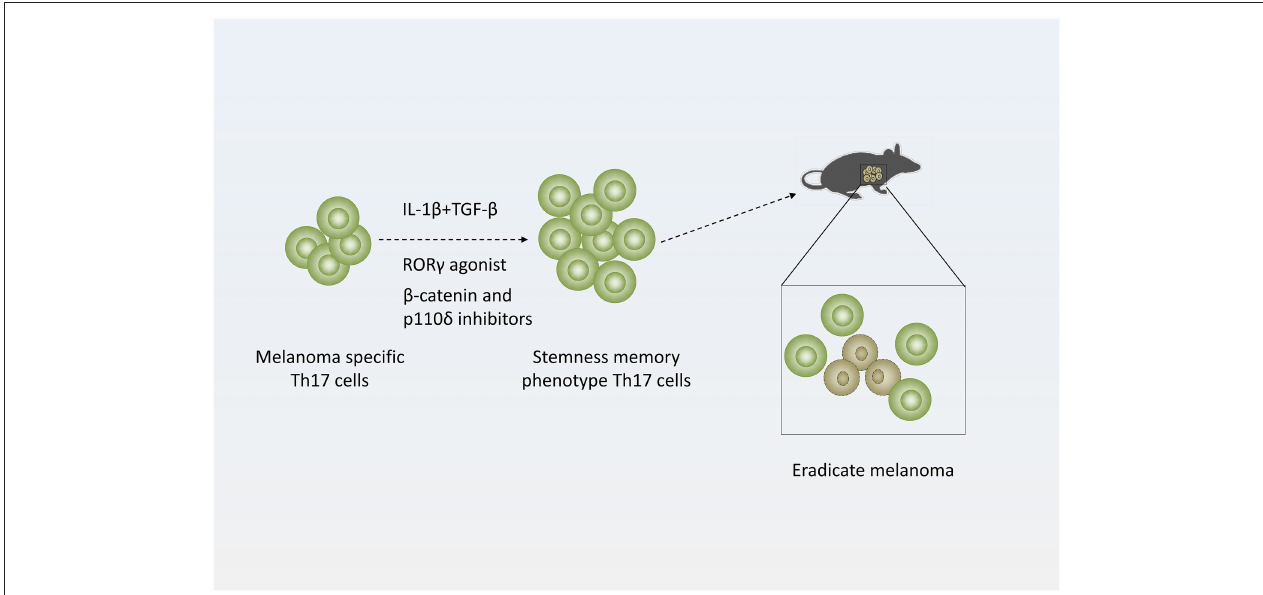
FIGURE 3 | Strategy of treating melanoma with Th17 cells. Adding distinct cytokines (IL-1 β and TGF- β simultaneously) or pharmacologic reagents (ROR γ agonist or β -catenin and p110 δ inhibitors) to Th17-polarized culture medium to generate stemness or memory Th17 cells, which are more efficient to eradicate melanoma.